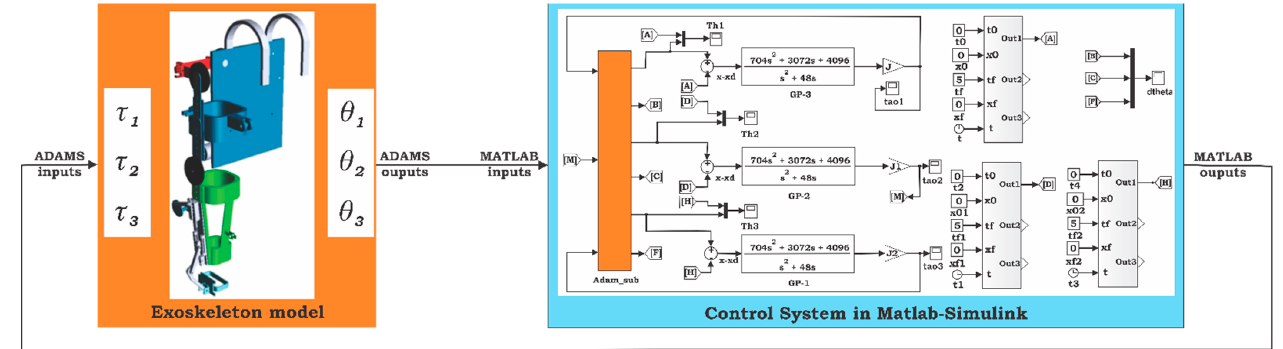
Figure 5. Block diagram in Simulink of robust GPI control in co ‐ simulation with MSC Adams view ® .